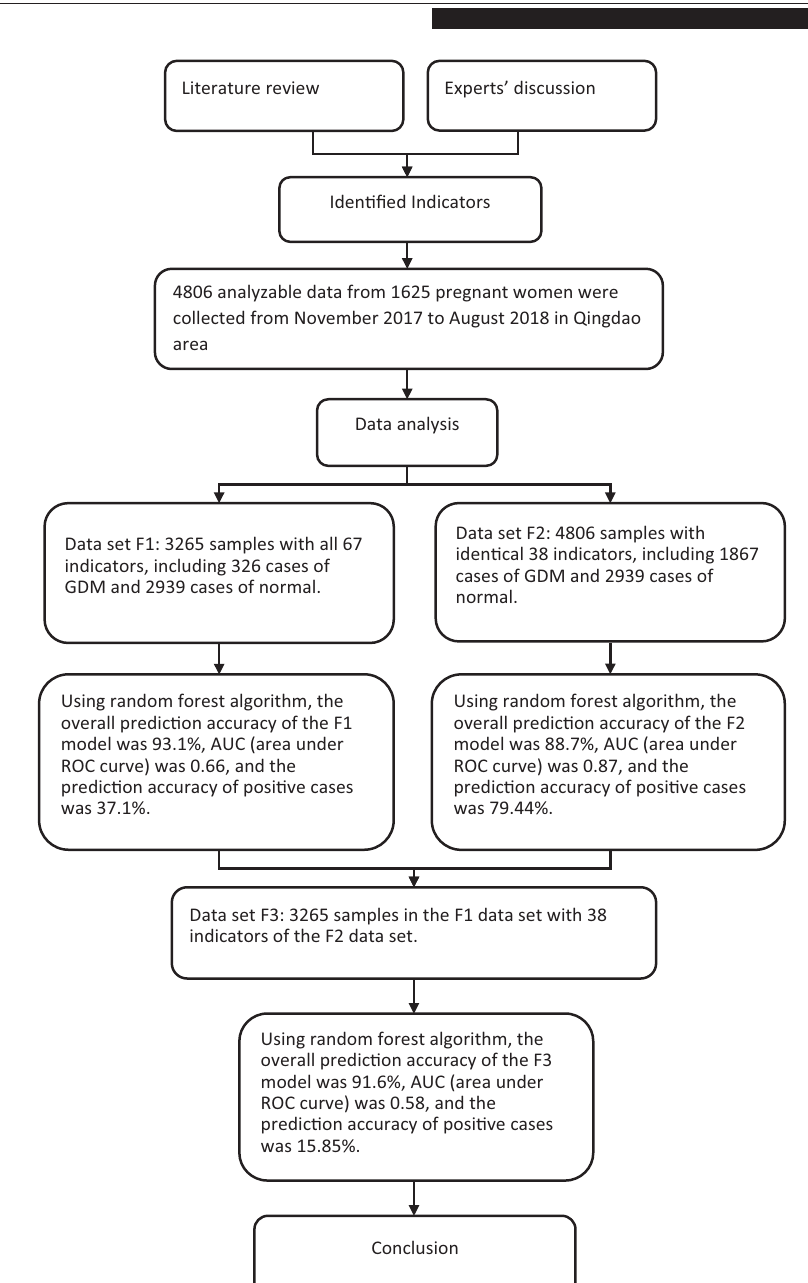
Figure 1. Technical